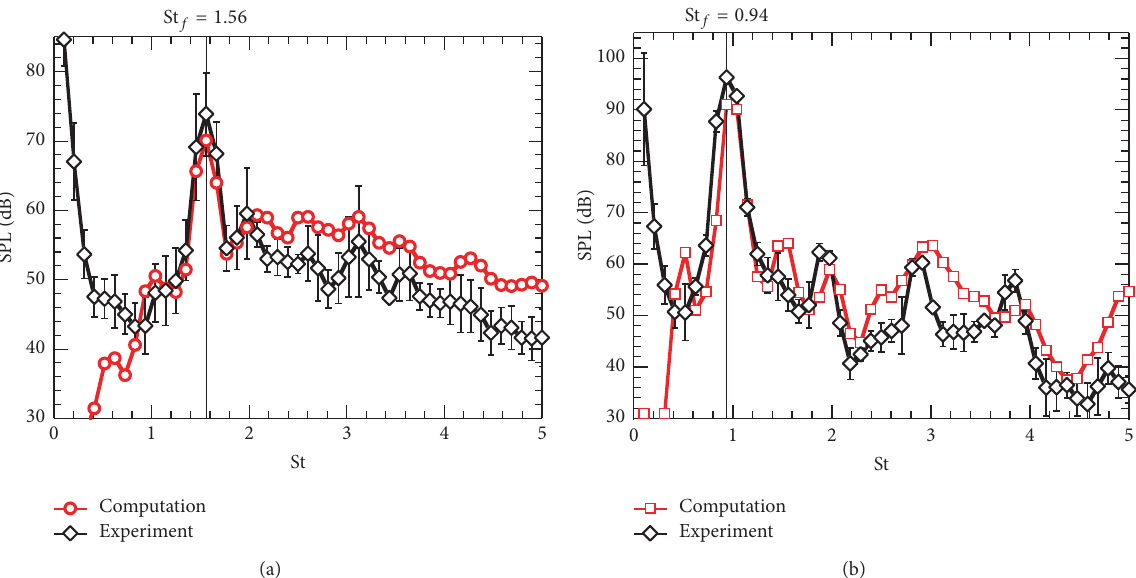
Figure 10: Comparison of predicted and measured sound pressure spectra ( 𝑥/𝐿 = 6.75 and 𝑦/𝐿 = 23.5). (a) Cavity flow without acoustic resonance ( 𝐷/𝐿 = 0.5). (b) Cavity flow with acoustic resonance ( 𝐷/𝐿 = 2.5).